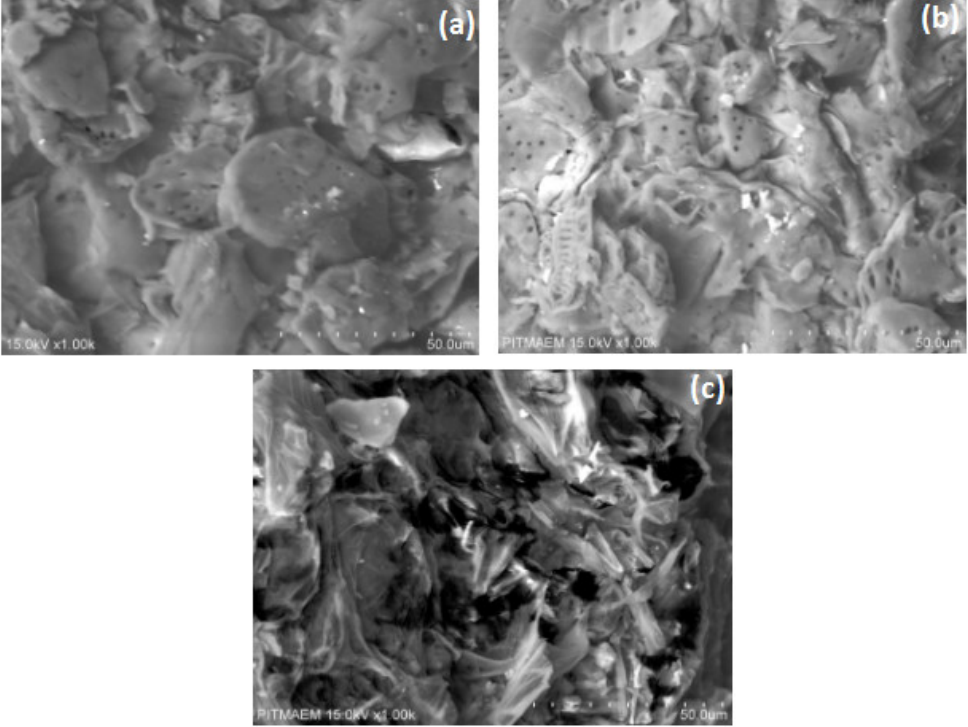
Figure 1. SEM images of B. ceiba biomass. ( a ) KOH-treated biomass, ( b ) KOH-steam-treated biomass, ( c ) untreated biomass.